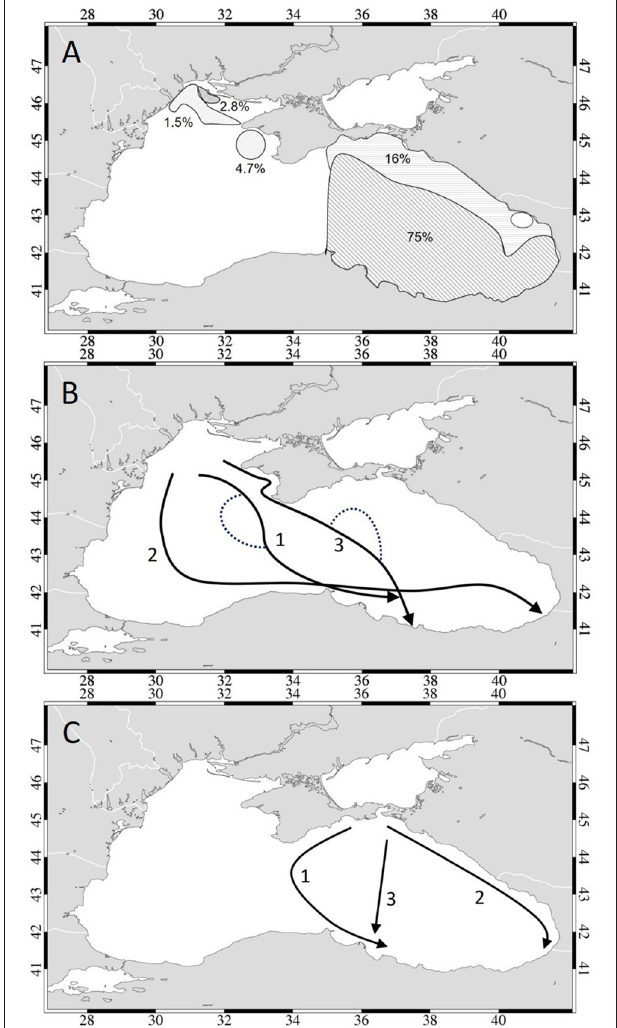
FIGURE 11 | Conceptual figure of (A) the regions from where anchovy can successfully reach the overwintering area when swimming along temperature gradients indicating the success rate of migration (%) from each region, showing the migration pathways identified for (B) Black Sea anchovy released from the northwestern shelf and (C) Azov anchovy released from the Kerch exit